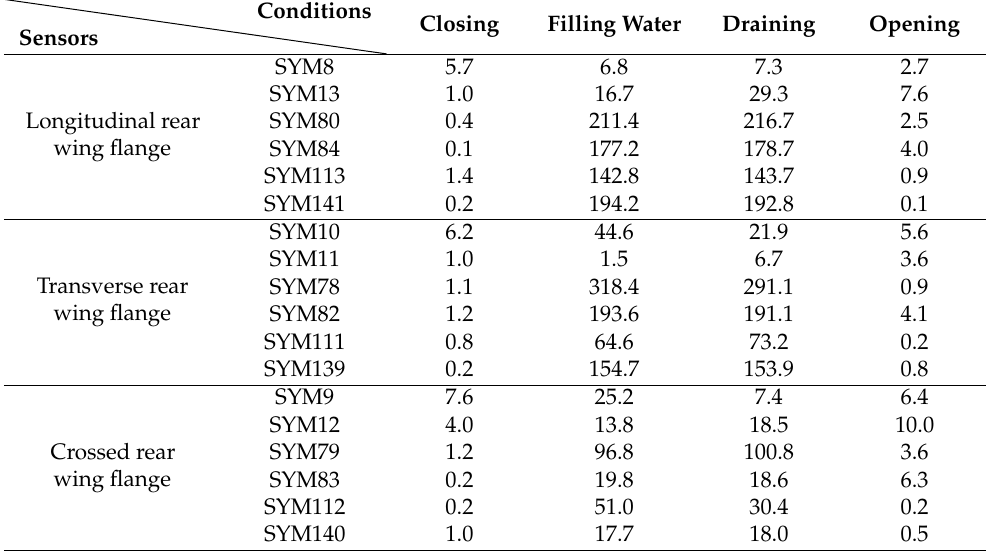
Table 2. Stress variation at different locations under different working conditions (MPa).